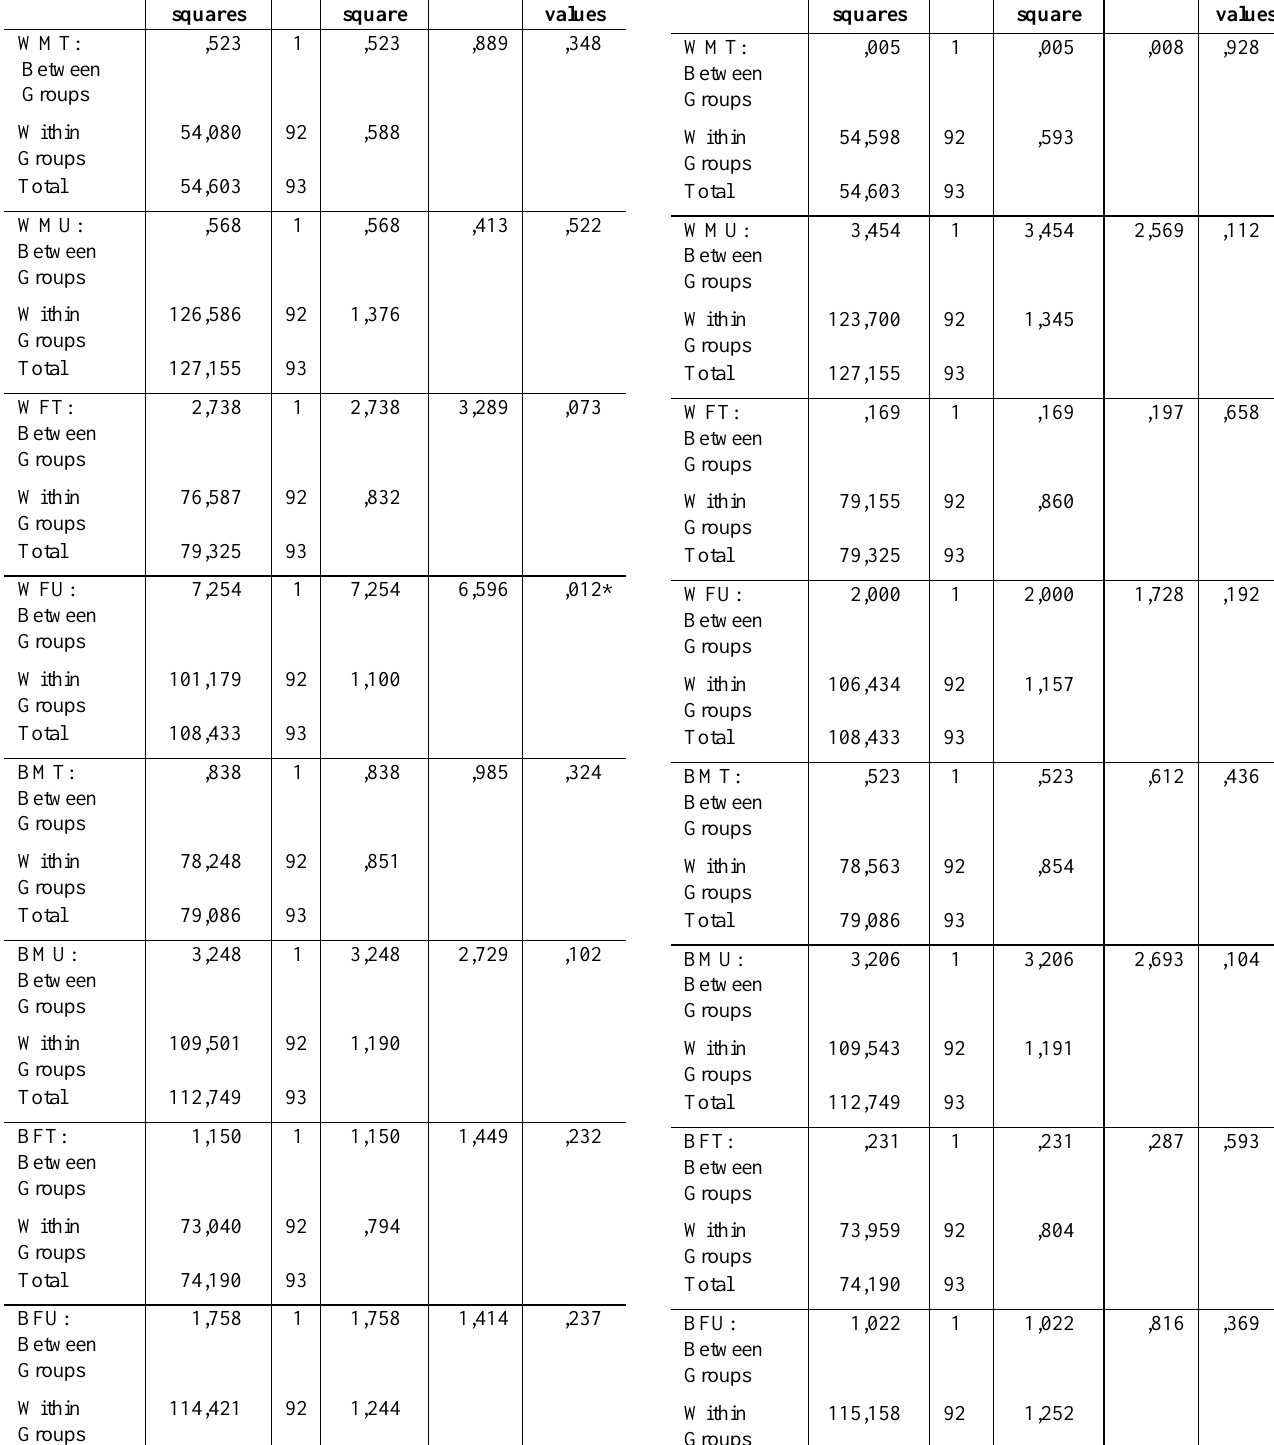
Table 3: ANOVA results: Main effect: race